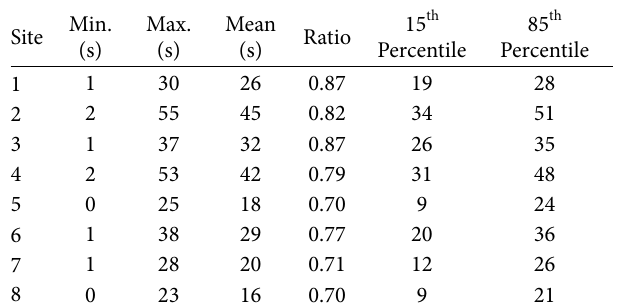
Table 3: Statistics of signal phase upon arrival, crossing decision and incomplete crossing.